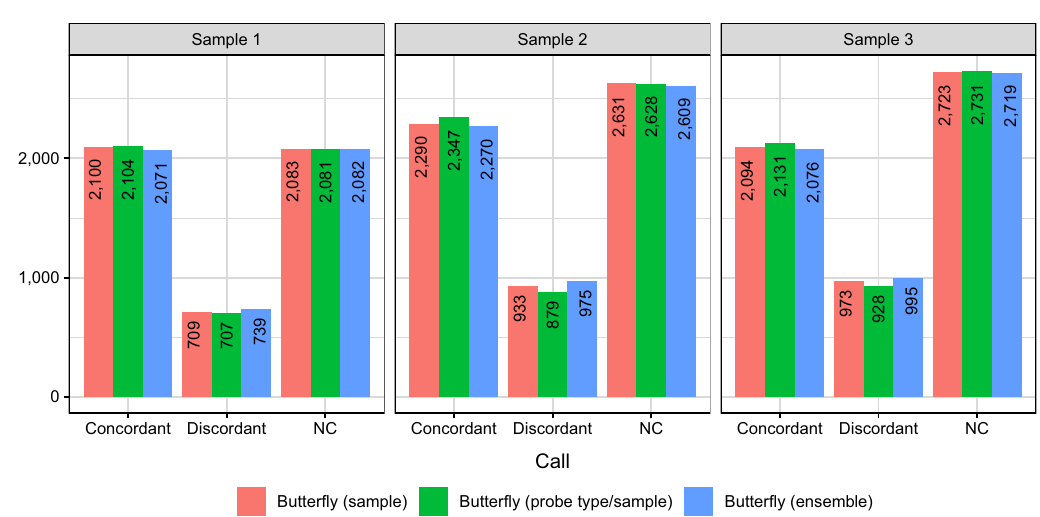
Butterfly (ensemble) Figure 9. Call distribution conditional on GenomeStudio making a NC for the samples with 400 ng DNA. The butterfly methods had an a posteriori probability threshold of 0.8 and a number of beads threshold of 0. The butterfly method also makes approximately 50% of these NC. Given a call is made, the calls of the butterfly and WGS methods are concordant in approximately 2/3 of